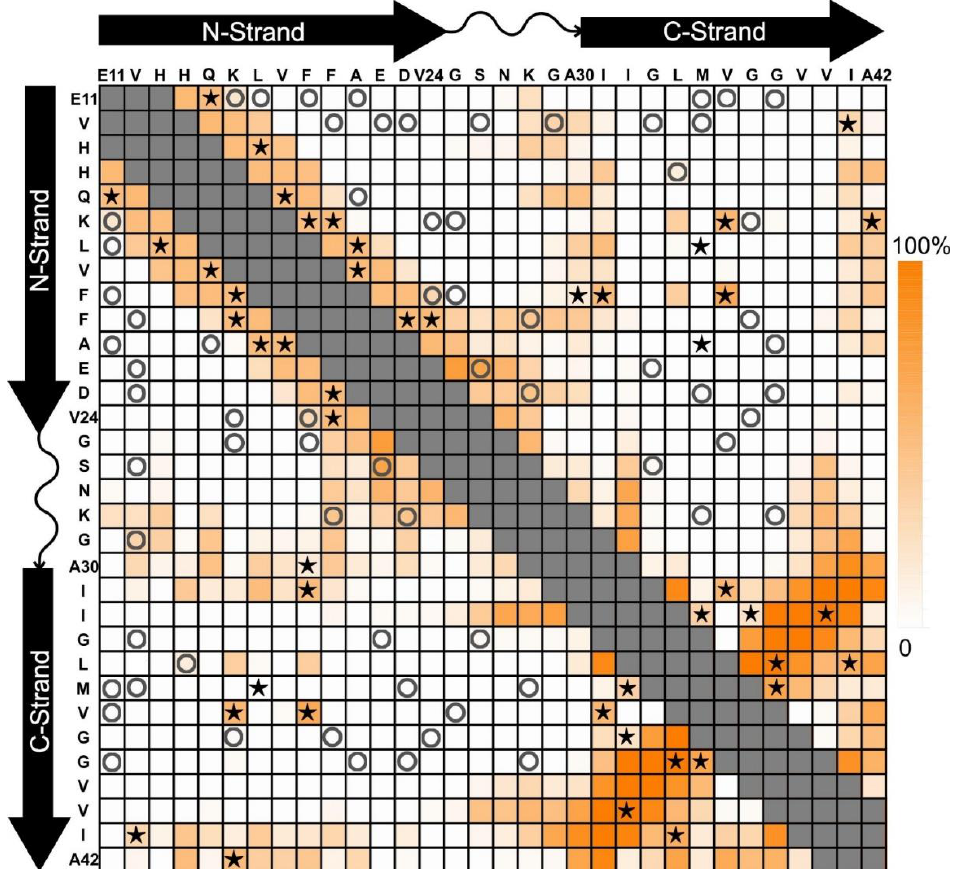
Figure 4. Chart of predicted and measured 2D DARR inter-residue contacts for the 150-kDa oligomer (see [30,34]). Symbols indicate when pairs of residues were isotopically labeled in the same sample and whether contacts were (stars) or were not (circles) observed. The color intensity scale (on right) indicates the model-predicted percentage that each residue pair would contribute to a 2D DARR-observable inter-residue contact in our model (see [34]). The conformation of the turn region (residues 24–29) and the interface between the b-sheets are not highly constrained. For pairs of residues corresponding to gray squares, intra-molecular 13 C- 13 C couplings would make it difficult to interpret contacts in terms of β-strand alignment.